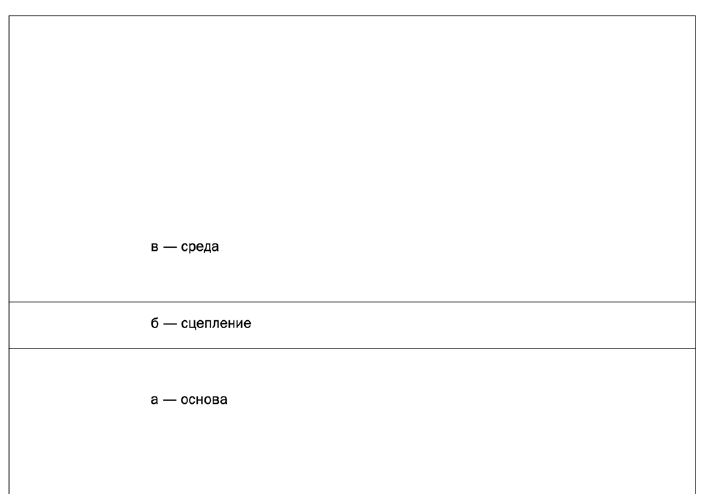
Figure 2. Structure of a color chart: the environmental background color ( top ); the “intermediary” linking color ( middle ); the main active color ( bottom ).